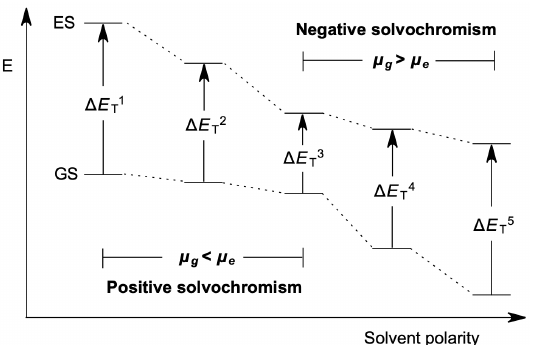
Figure 1. Schematic representation of the influence of the solvent polarity on electronic transition energy in dipolar solvatochromic dyes [11,12].